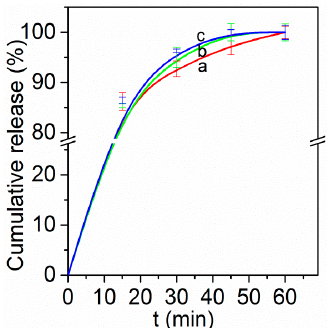
Figure 8. Cumulative release of lysine in PBS solutions from the microparticles obtained with an ethanol/water solvent of 4:1 volume ratio at a drying temperature of 100 ( a ); 155 ( b ); and 205 °C ( c ), respectively.